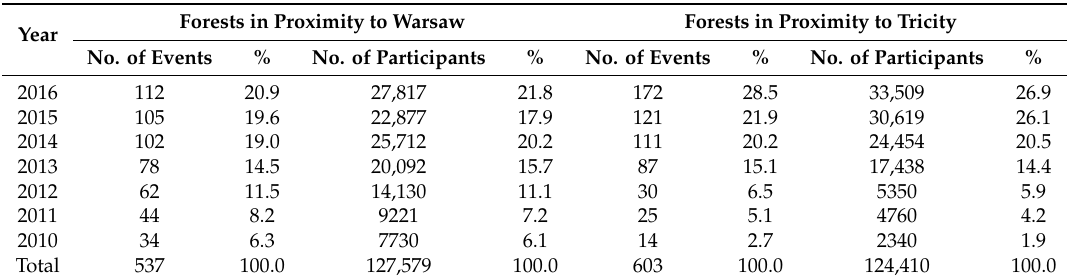
Table 1. The number of sporting events and the number of participants in the vicinity of the urban agglomerations of Warsaw and Tricity in